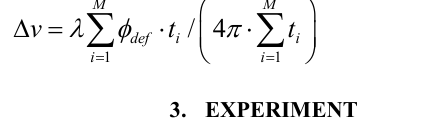
Figure 1. Study area In Figure 1, the red line stands for the railway line. A stand for Longyang Road Station, B stand for Pudong Airport, and C stand for Chuansha Town. By monitoring the settlement of the buildings surrounding the line, the deformation changes during the subway construction is analyzed, and the relationship between the development of the subway construction and the surrounding building settlement can be used to evaluate the safety of the railway line.